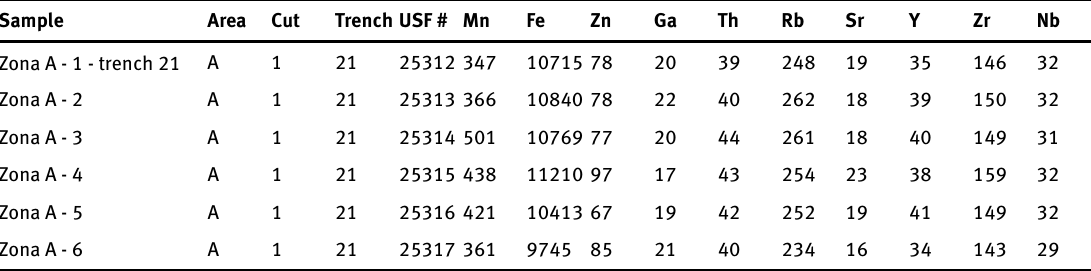
Table 5. Calibrated data for the pXRF analyses of 150